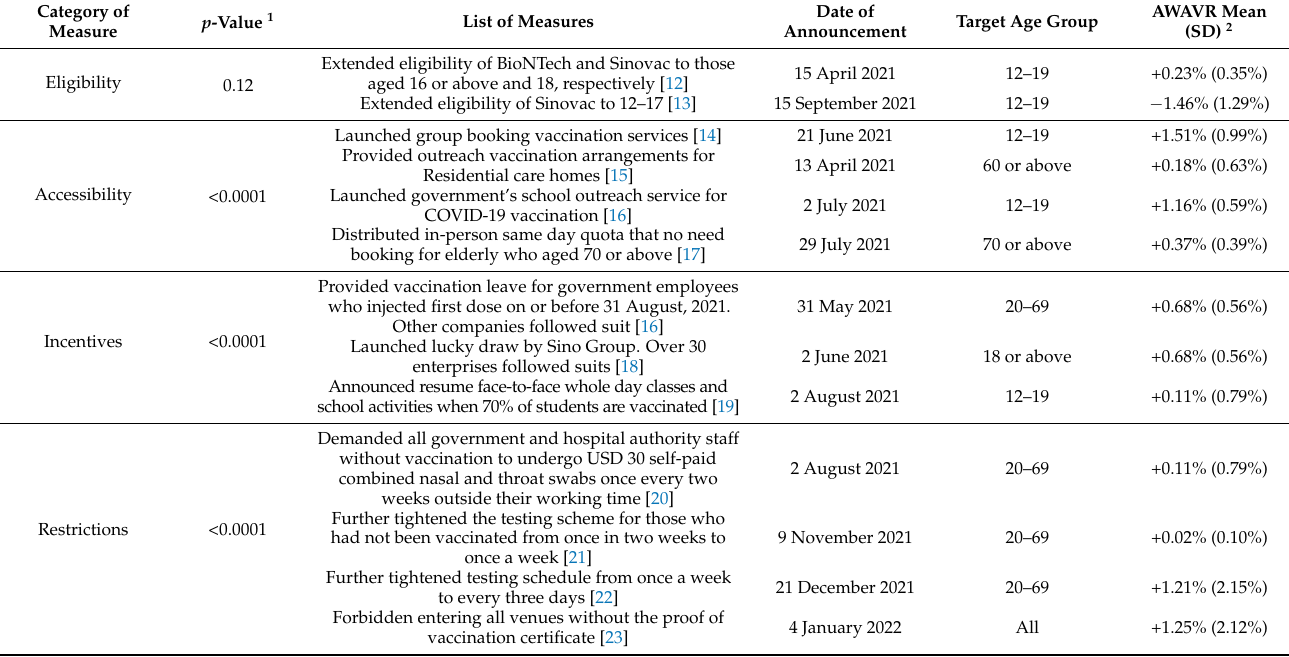
Table 1. Effectiveness of